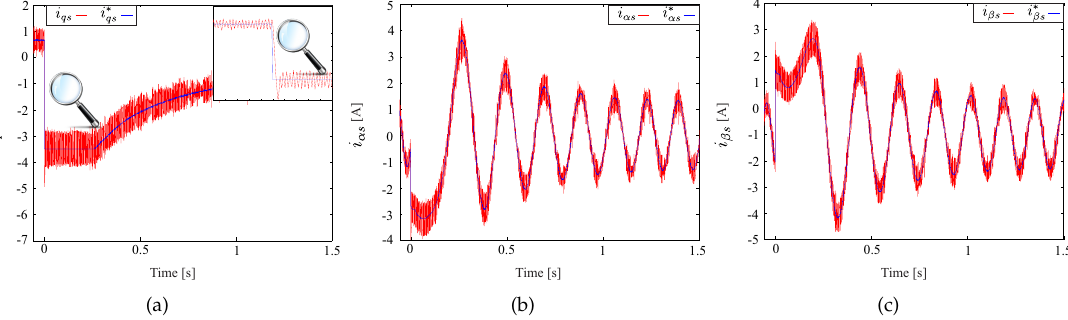
Figure 5. Transient response of stator currents from a step response of 500 rpm to − 500 rpm from ω m at a frequency sample of 8 kHz: ( a ) i qs ; ( b ) i α s ; ( c ) i β s